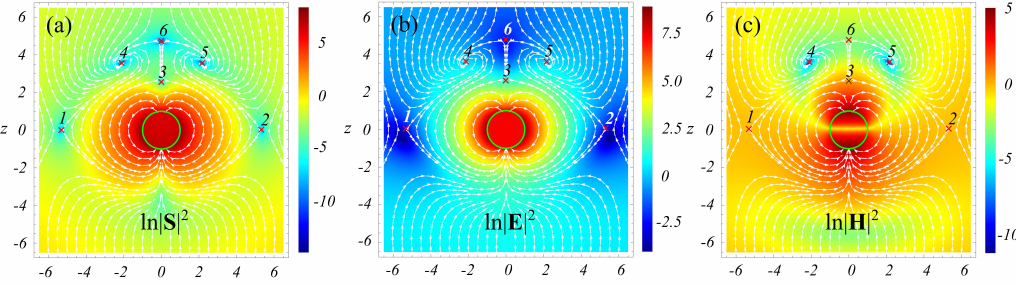
Figure 1. Light scattering by a sphere in a vacuum. Streamlines for the Poynting vector field and the logarithm of the square of the modulus of the Poynting vector ( a ), electric ( b ), and magnetic ( c ) fields in the invariant plane passing through the sphere’s center and coinciding with the plane of vector E oscillations. q = 0.3, ε = − 2.17. The pattern is symmetric with respect to the line x = 0. Crosses marked with numbers are the positions of singular points. Points 4 and 5 are foci; the rest are saddles. | S | 2 = 0 at all singular points. The foci and saddles are the H-field-induced and polarization-induced singularities, respectively. See text for